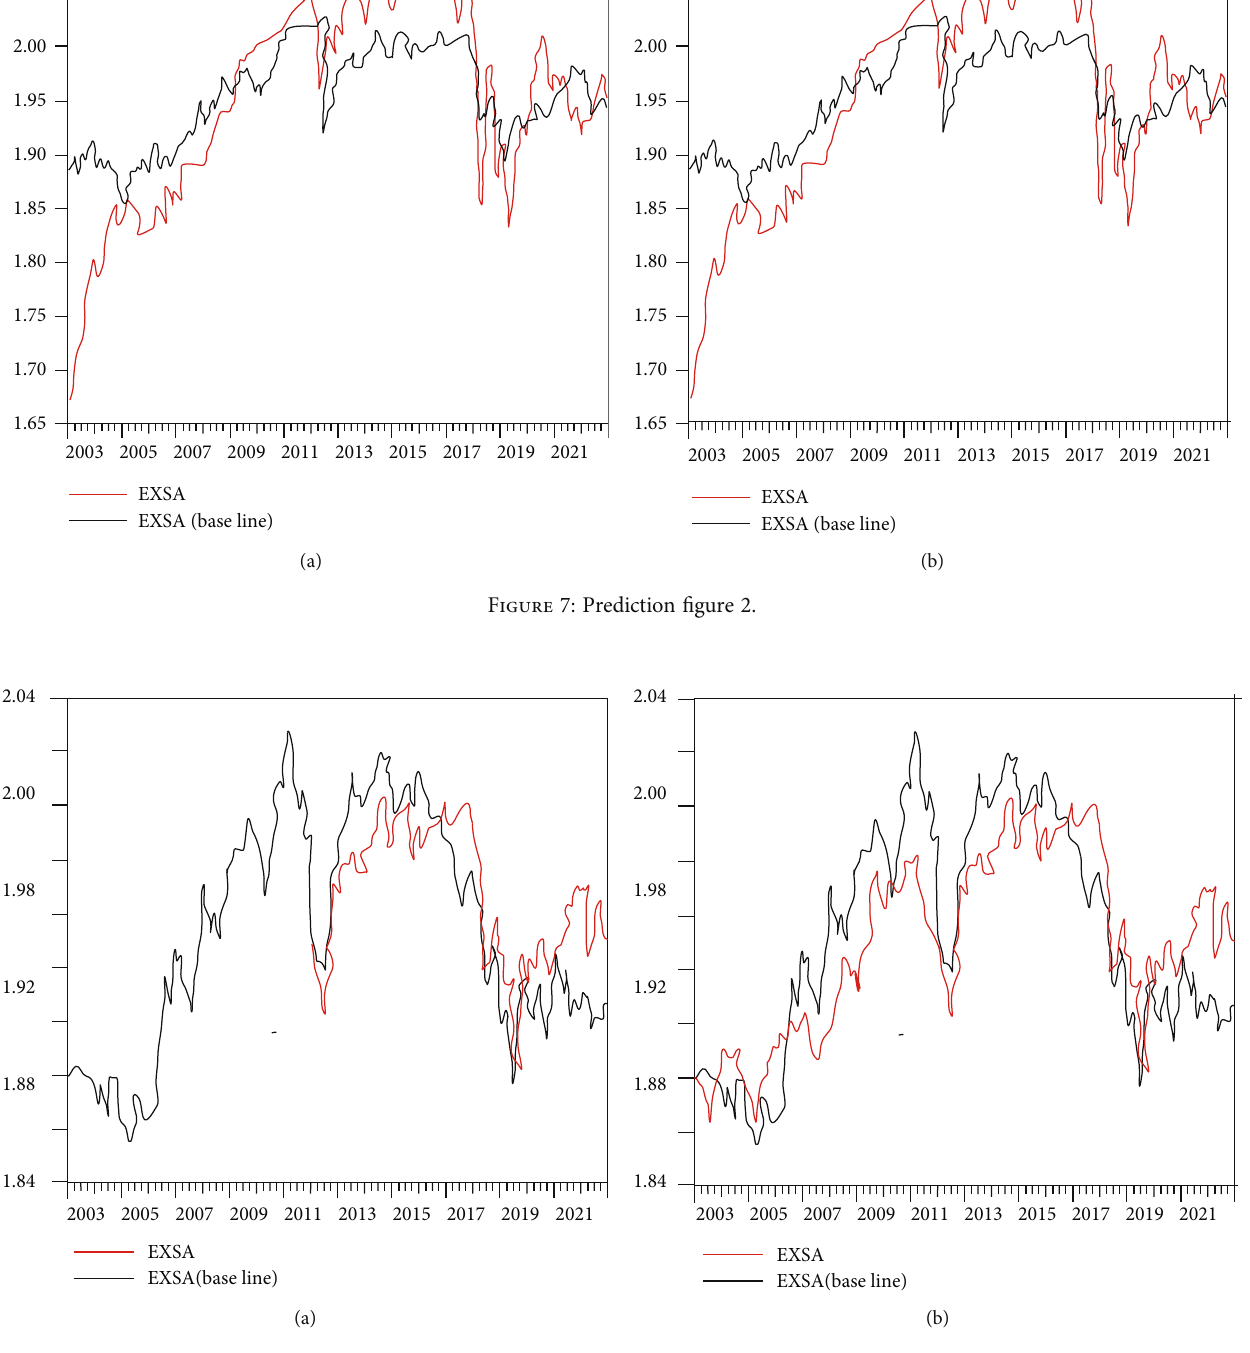
Figure 8: Prediction fi gure